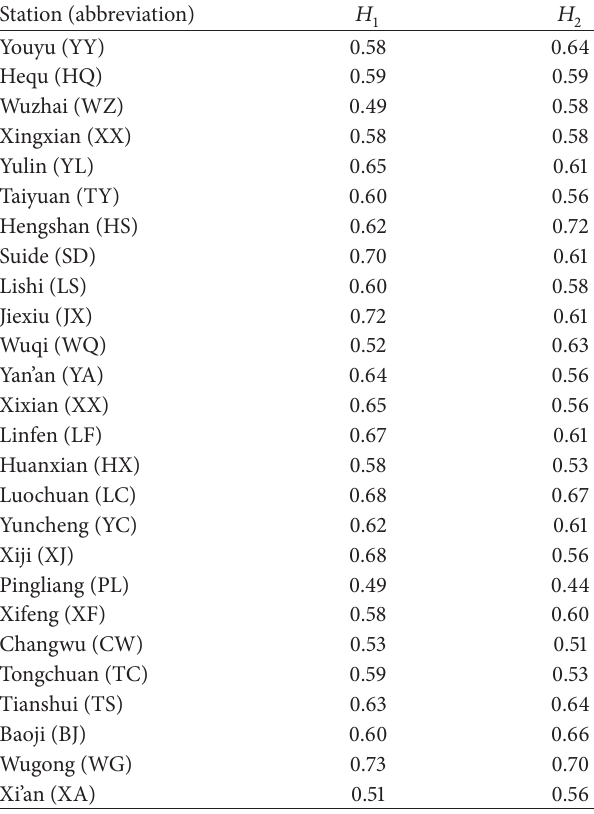
Table 5: Hurst exponent analysis for 𝑃 𝑓 and 𝑃 mf during 1958–2013 in the